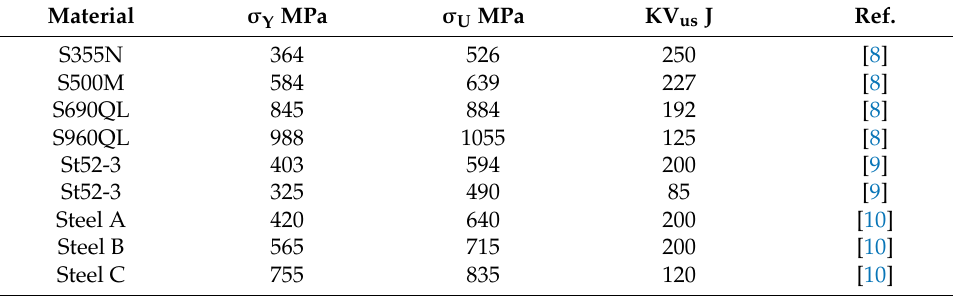
Table 1. Mechanical properties of the materials